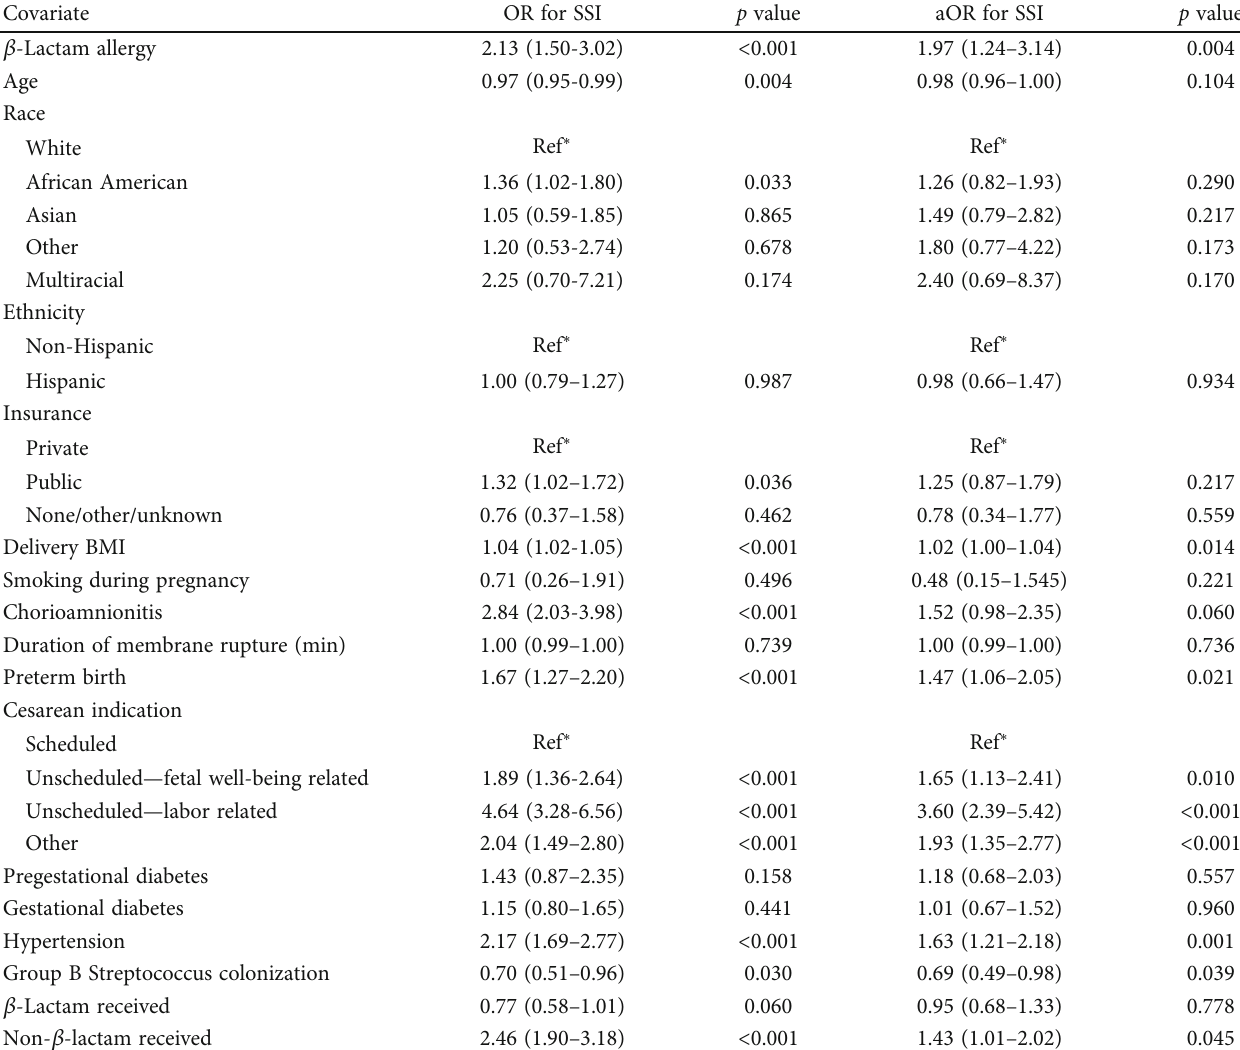
Table 3: Unadjusted and adjusted association between maternal and obstetric characteristics, including β -lactam allergy and surgical site